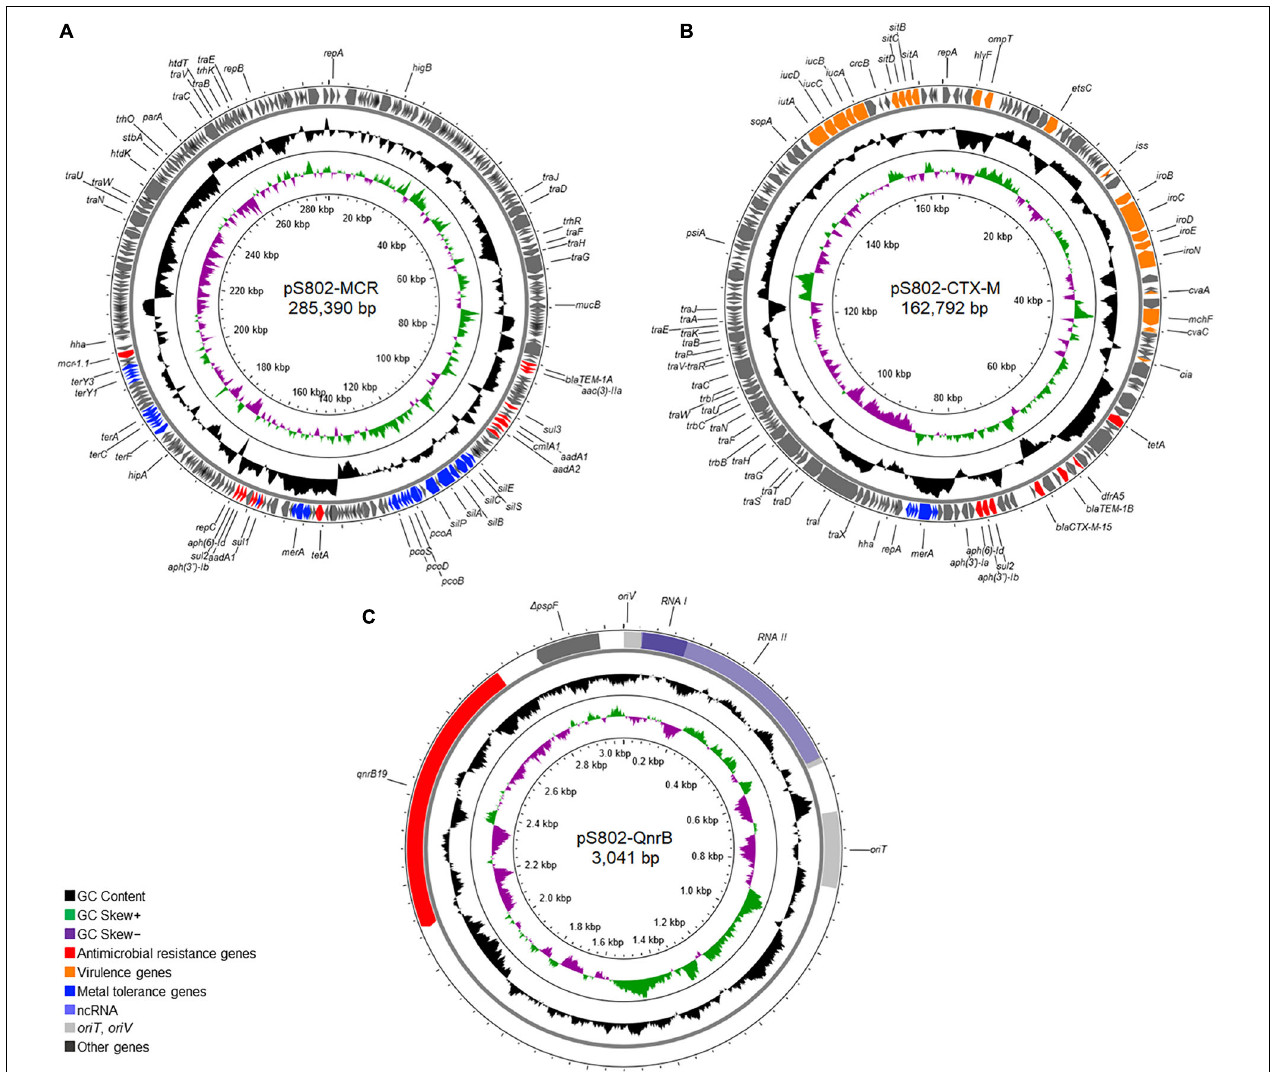
FIGURE 3 | Overview of the plasmids (A) pS802-MCR, (B) pS802-CTX-M, and (C) pS802-QnrB carrying mcr-1.1 , bla CTX − M − 15 , and qnrB19 , respectively, in E. coli